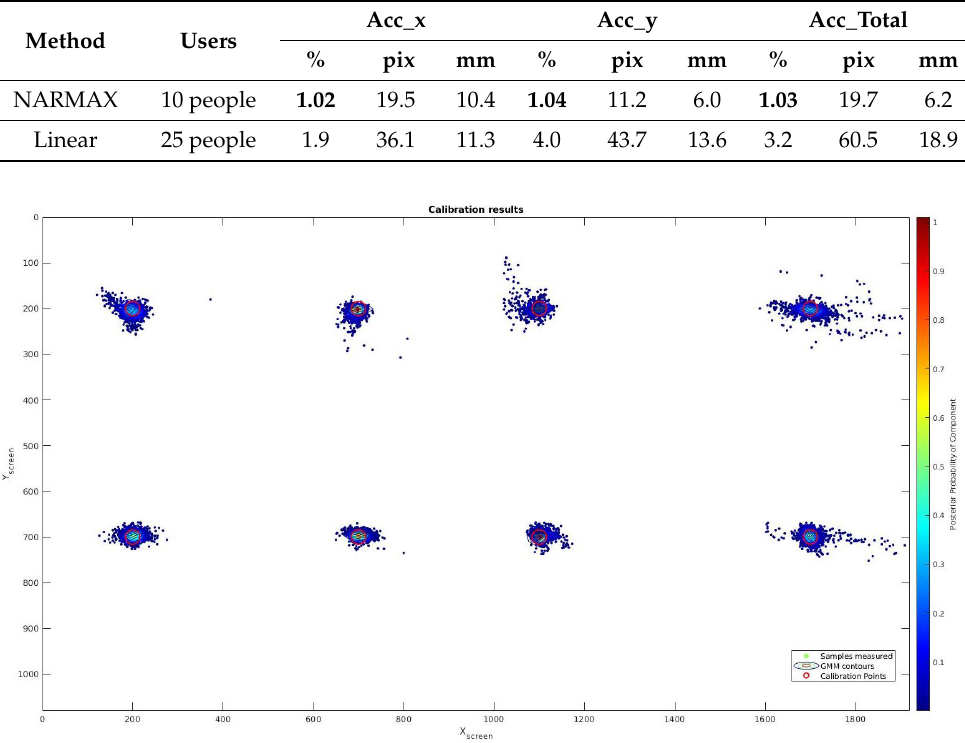
Table 4. Testing accuracy on a 1920 × 1080 screen. Test done by 10 users looking at eight points on a screen using the NARMAX calibration method.